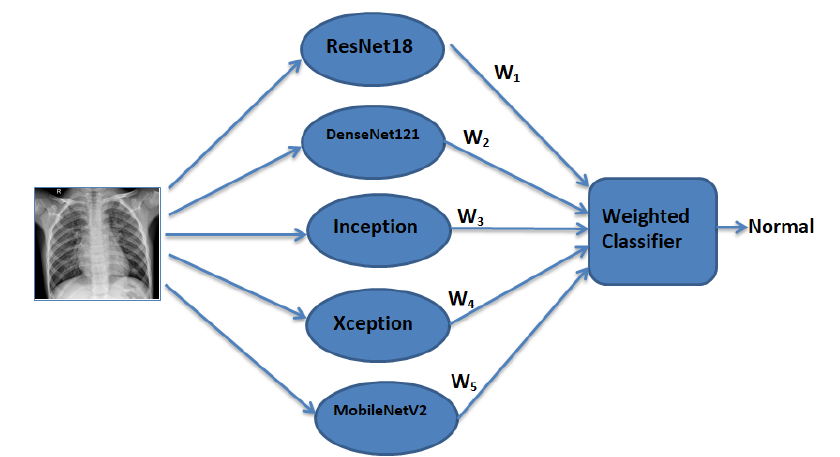
Figure 6. Weighted classifier module used in this paper (weighted predictions from all the models are passed to the weighted classifier, which gives the final weighted